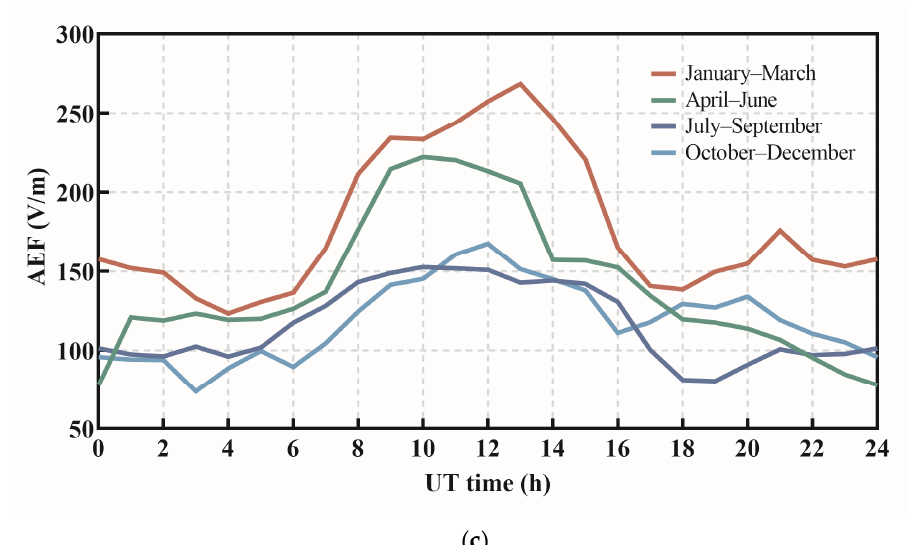
Figure 2. The daily variation curves of the average fair-weather AEF in different seasons for the RDG station, the ZH station, and the XAN station in 2021 (( a – c ) correspond to the RDG station, the ZH station, and the XAN station, respectively. The red curve indicates January–March, the green curve represents April–June, the dark blue curve is July–September, and the light blue curve indicates October–December.).